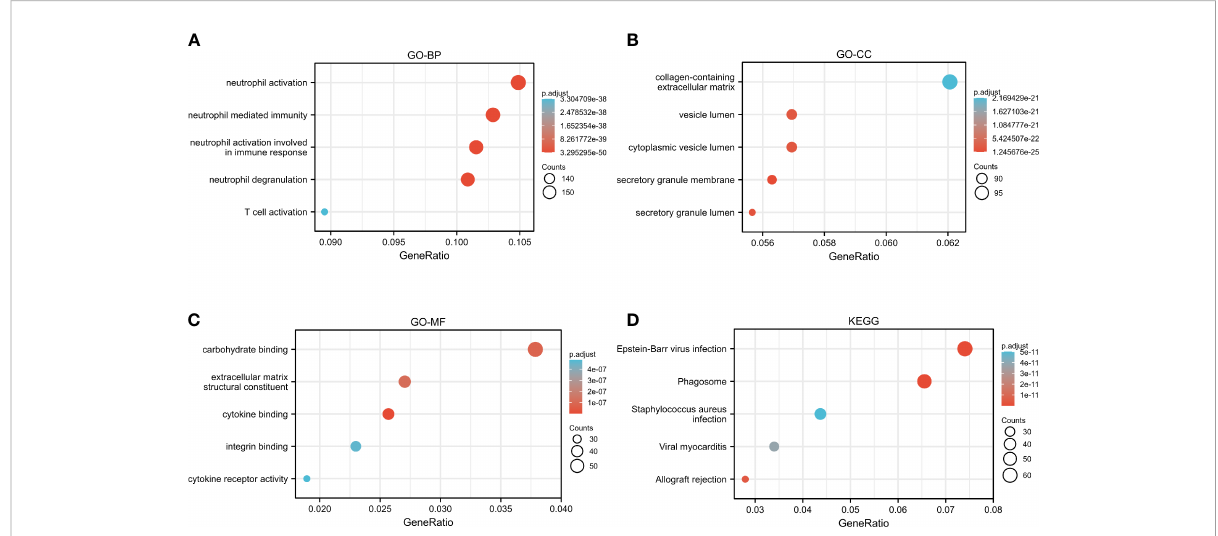
FIGURE 7 Functional analysis of CASP4 in patients with gliomas. (A – C) GO analysis of CASP4 co-expression genes. (A) Biological process. (B) Cellular component. (C) Molecular function. (D) KEGG pathway enrichment analysis of CASP4 co-expression genes. GO, Gene Ontology; KEGG, Kyoto Encyclopedia of Genes and Genomes.